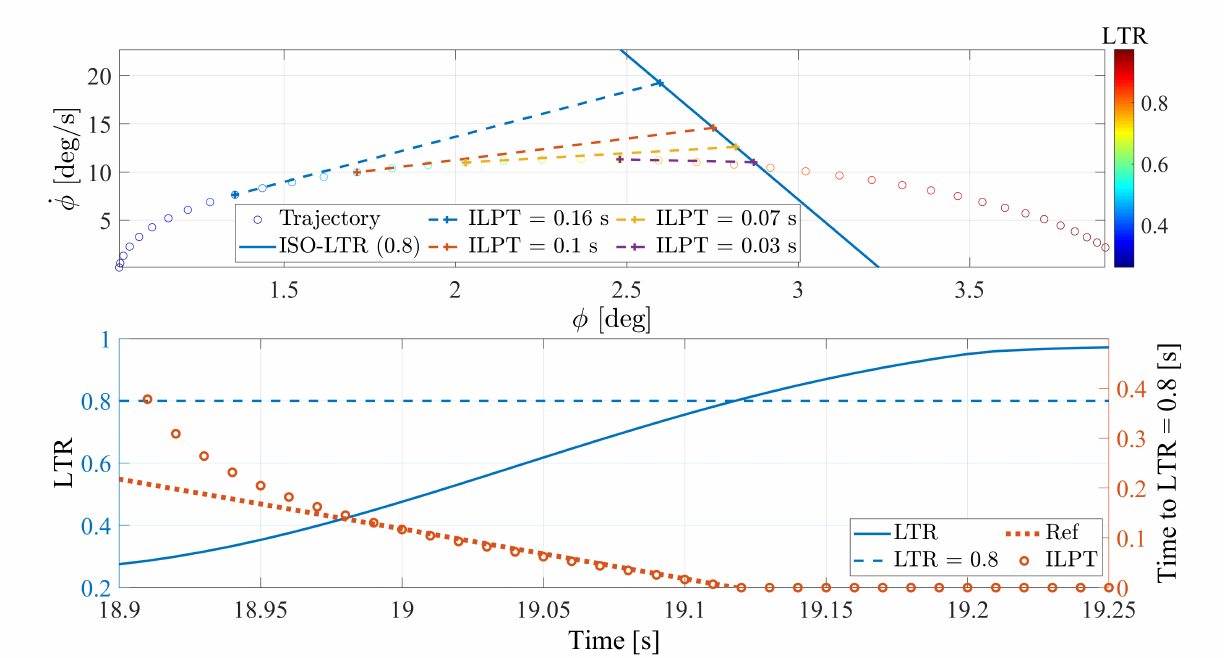
from the rollover risk, the ILPT (red circles) deviates from the T Ref (red dashed line)